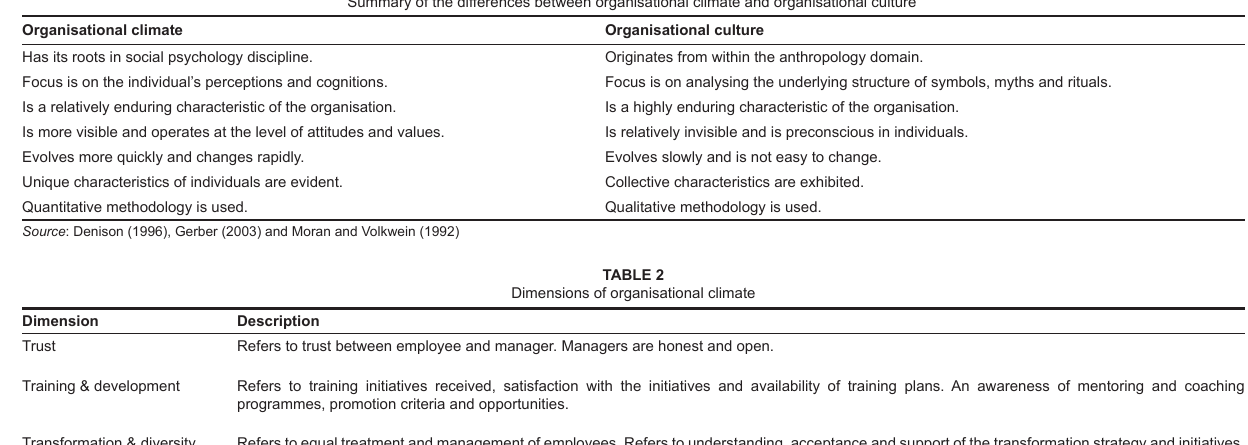
Table 1 Summary of the differences between organisational climate and organisational culture Organisational climate Organisational culture